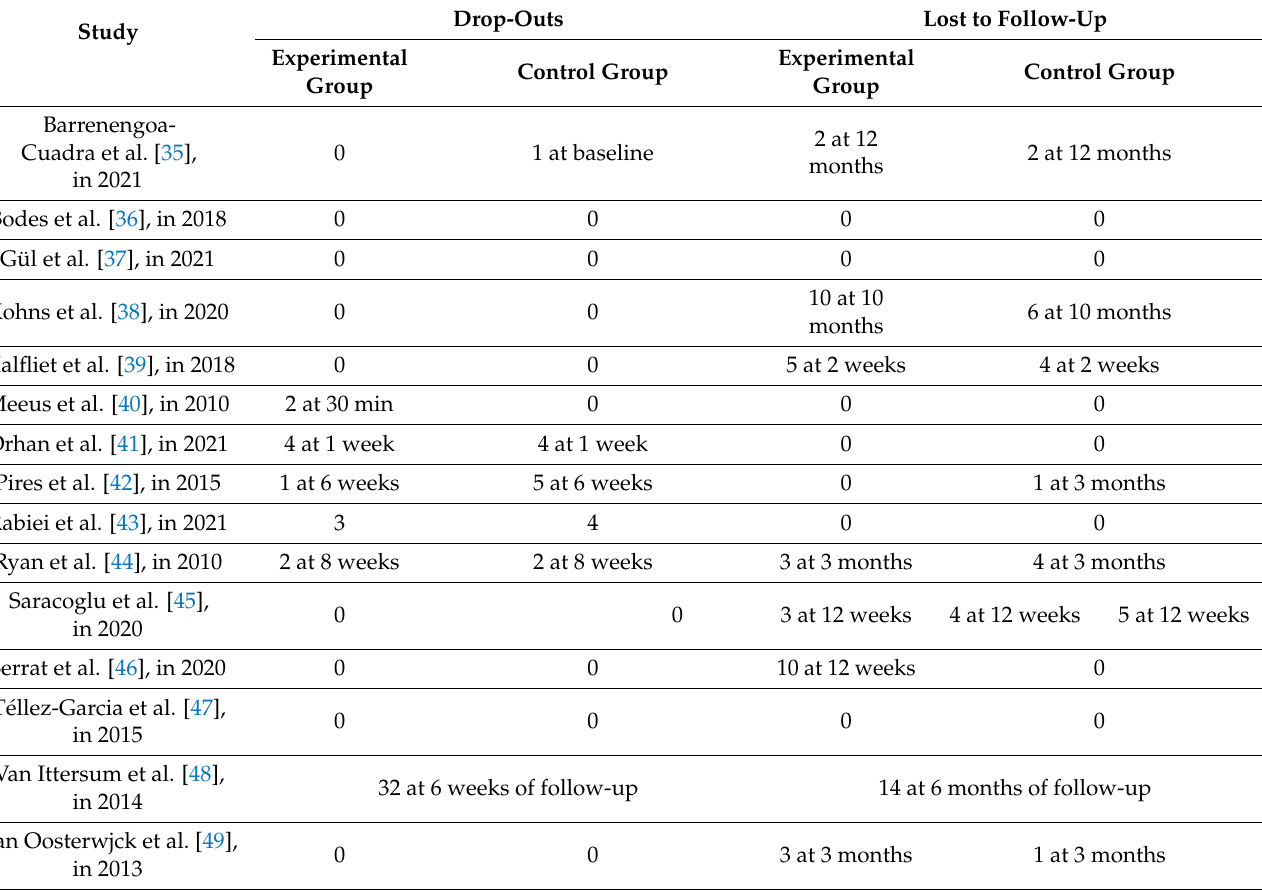
Table 2. Drop-outs and lost to follow-up in the included